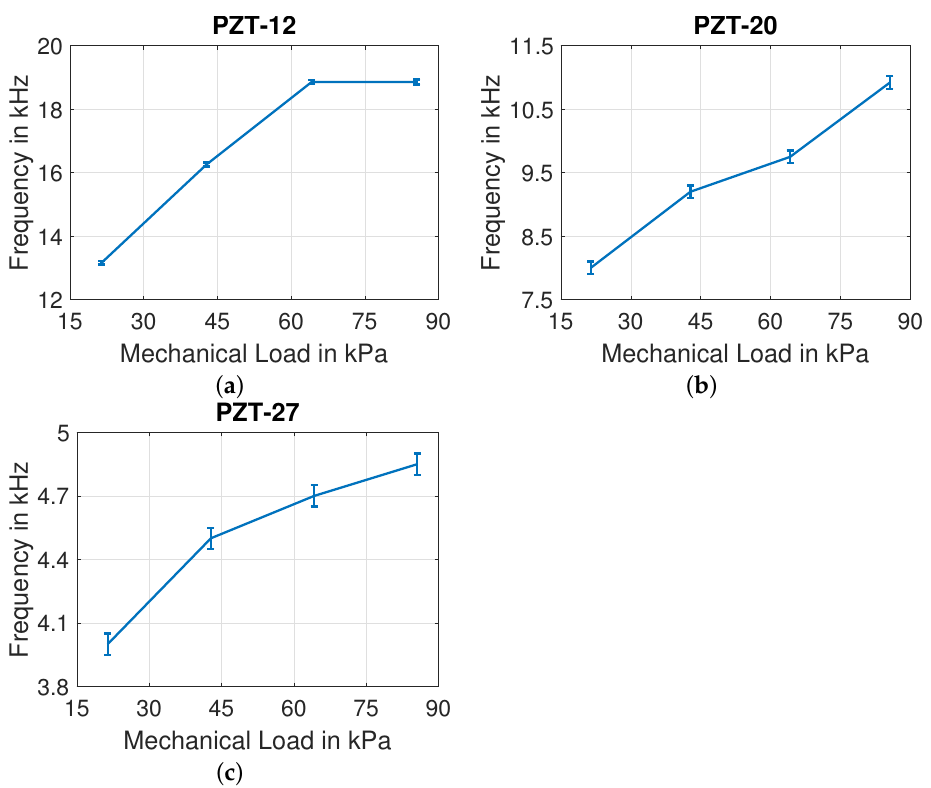
Figure 18. Influence of mechanical load on first resonant frequency of ( a ) PZT-12, ( b ) PZT-20, and ( c ) PZT-27.